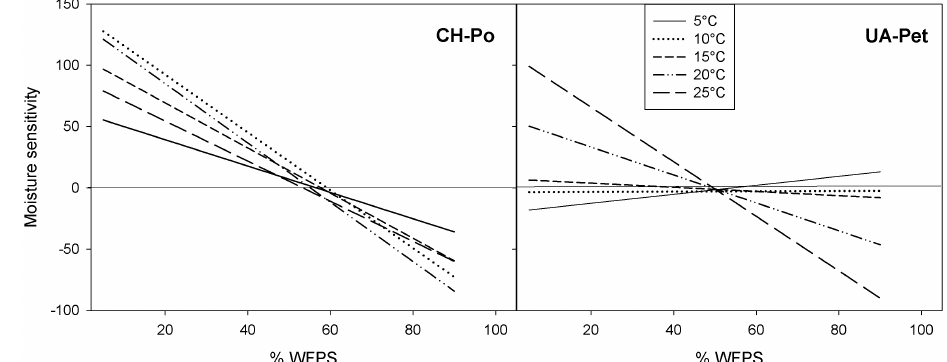
Figure 4. Illustrated moisture sensitivity (MS) of relative CO 2 efflux from the grassland site CH-Po and the arable site UA-Pet in relation to soil moisture content for all temperatures investigated. MS was calculated as the slope of a polynomial function of second degree. The cutpoint on the x axis indicates optimum moisture content for CO 2 emissions at their respective temperature. Negative values of moisture sensitivity after reaching the optimum moisture content (MC Opt ) indicate a decrease in CO 2 emissions with increasing moisture content; positive values indicate an increase in CO 2 emissions with increasing moisture